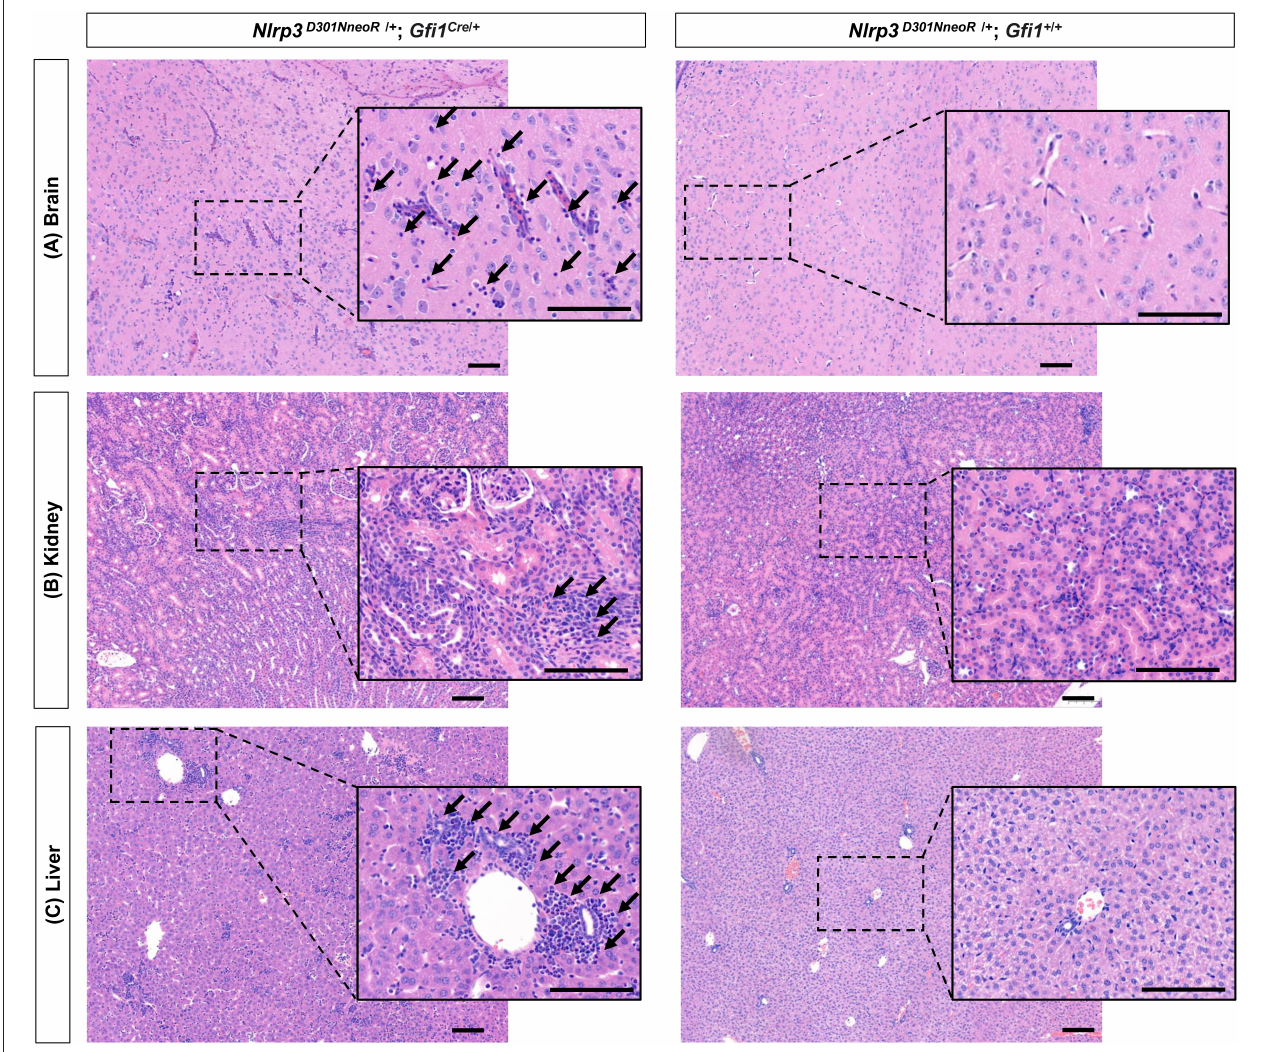
FIGURE 7 | Generalized inflammation observed in several organs of Nlrp3 D 301 NneoR / + ; Gfi1 Cre / + mice compared to Nlrp3 D 301 NneoR / + ; Gfi1 + / + mice. Representative image of inflammation at P20 in (A) brain (thalamus), (B) kidney, and (C) liver sections of Nlrp3 D 301 NneoR / + ; Gfi1 Cre / + mice (left panels) compared to normal findings in Nlrp3 D 301 NneoR / + ; Gfi1 + / + mice (right panels). Diffuse lymphocytic infiltration can be seen throughout the whole section. Insets show enlarged views of the dotted areas. Black arrows denote examples of areas with lymphocytic infiltration. P20, postnatal day 20. The scale bars represent 100 µ